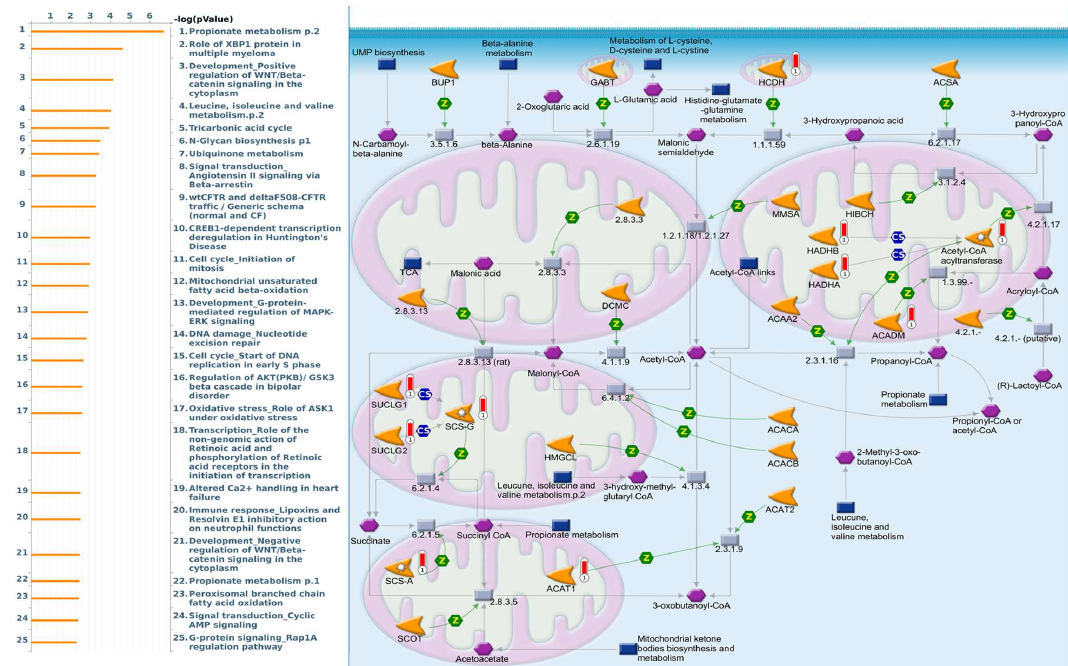
Figure 6. MetaCore pathway analysis of the coexpression gene network of proteasome 20S subunit alpha 2 (PSMA2) in breast cancer patients. We used the MetaCore platform to analyze genes coexpressed with PSMA2 from the associated METABRIC and TCGA datasets, and downstream pathway analyses revealed that “Propionate metabolism p.2” participates in breast cancer development.